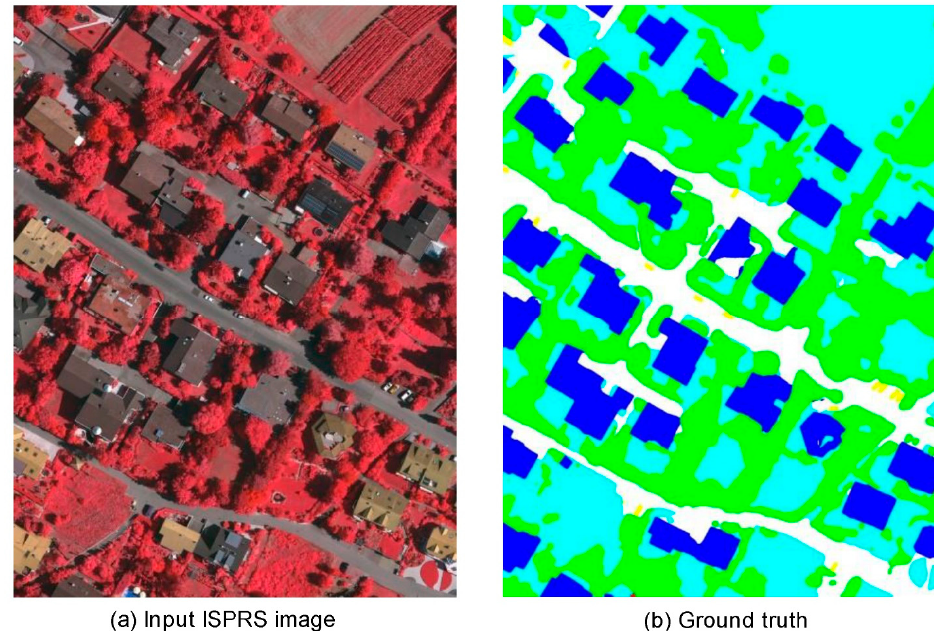
Figure 7. An input image sample and its ground truth in the ISPRS dataset. ( a ) This picture shows one of the input images of the ISPRS dataset. ( b ) The picture shows the ground truth corresponding to the picture in ( a ).